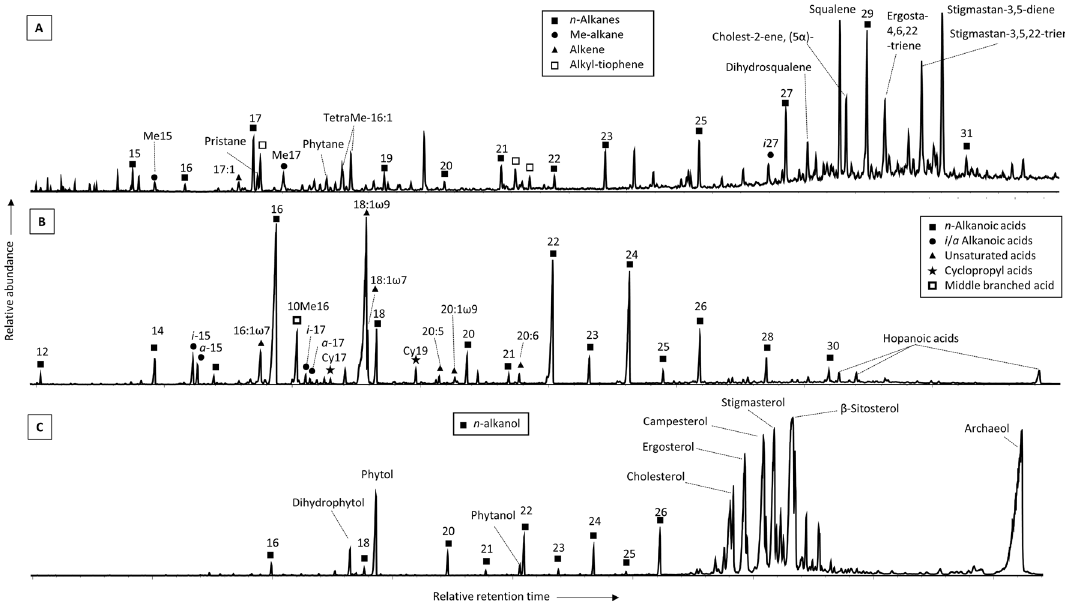
Figure 3. Mass chromatograms (represented as total ion current) of the three polarity fractions extracted from the dry sediments in the Tirez lagoon in 2021; ( A ) apolar fraction containing linear and saturated ( normal ) alkanes ( n -alkanes), branched (methylated) and unsaturated (chains with double bonds) hydrocarbons, isoprenoids, and steranes; ( B ) acidic fraction with alkanoic acids of normal , branched, unsaturated, and cyclopropyl chains; and ( C ) polar fraction including n -alkanols, phytol and derivatives, archaeol and